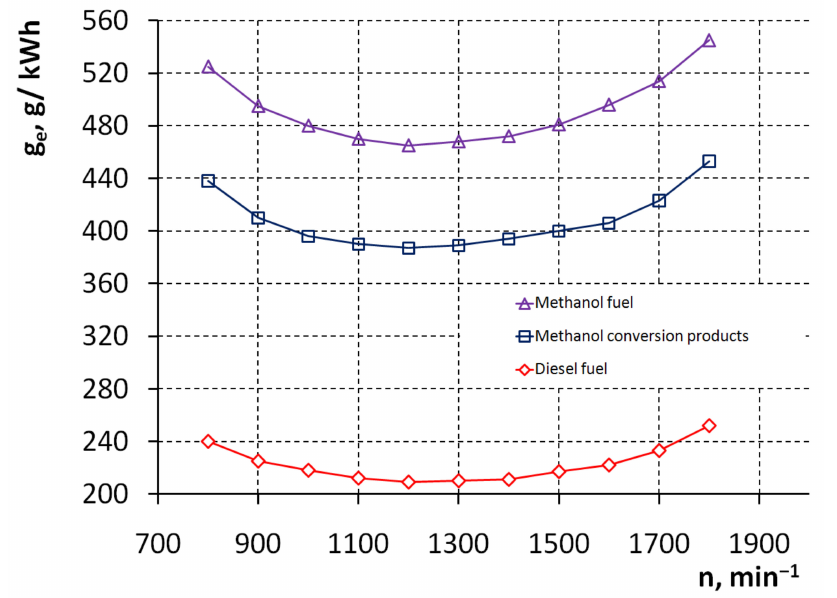
Figure 9. Experimental dependences of specific fuel consumption on the crankshaft speed of the engine n for different motor